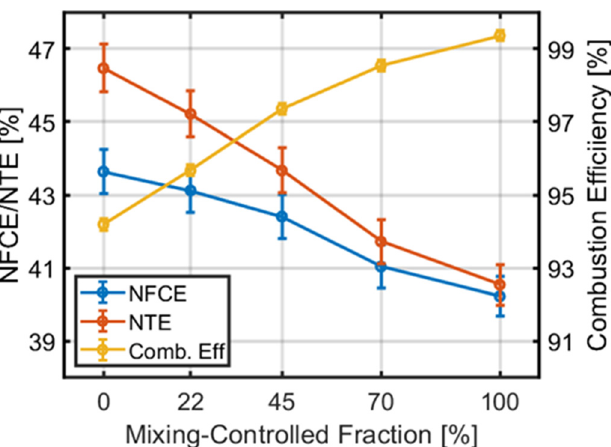
Figure 11. Net fuel conversion (FC) efficiency, net thermal efficiency, and combustion efficiency vs. mixing-controlled fraction.